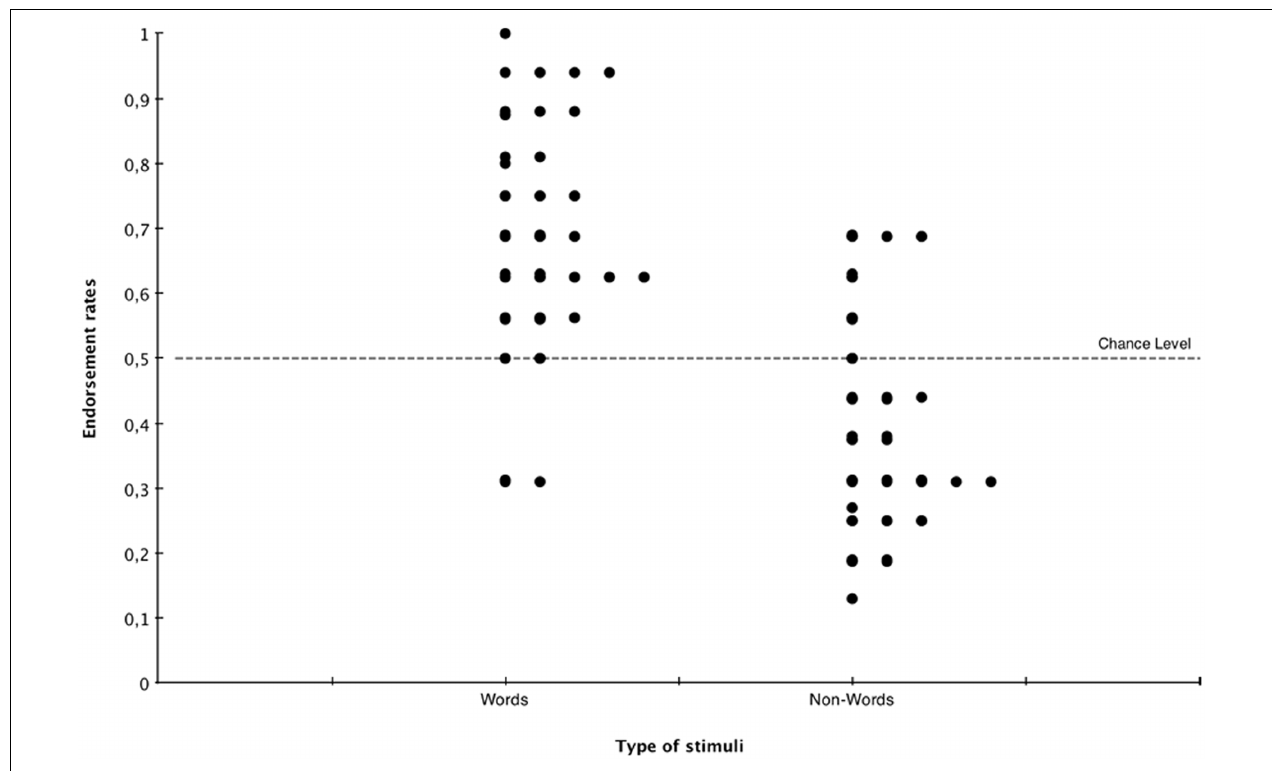
FIGURE 4 | Endorsement rates for words and for non-words in the inclusion task.